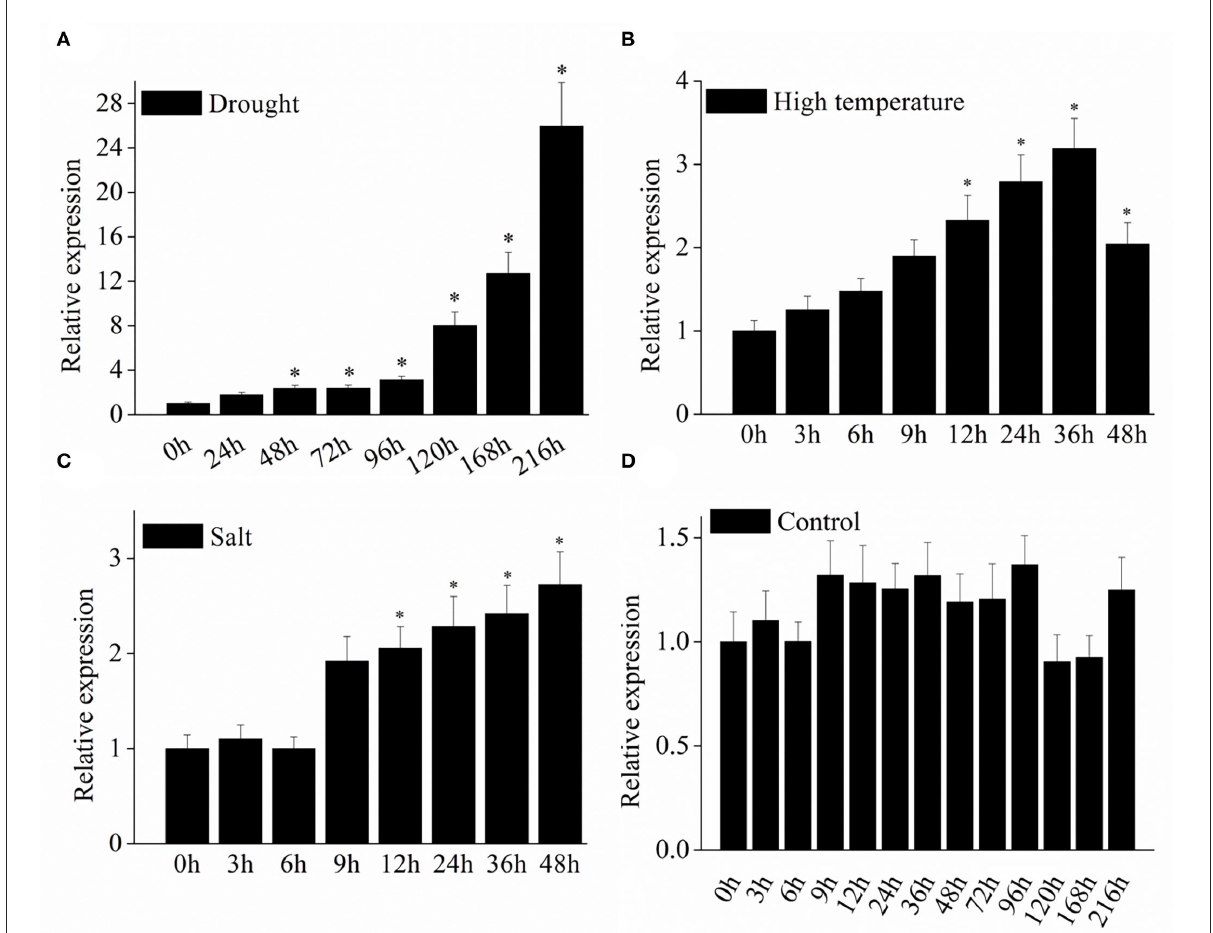
FIGURE5 The expression profiles of the VyMYB24 gene in V. yanshanesis accession Yanshan-1 leaves under abiotic stresses. The two-year-old Yanshan-1 seedlings were treated with drought (A) , high temperature of 40 ◦ C (B) , and high salt of 0.1M NaCl (C) with normal as CK (D) . The data represents the means ± SD of three replicates and the statistical analyses were performed with a one-way ANOVA test, * p <